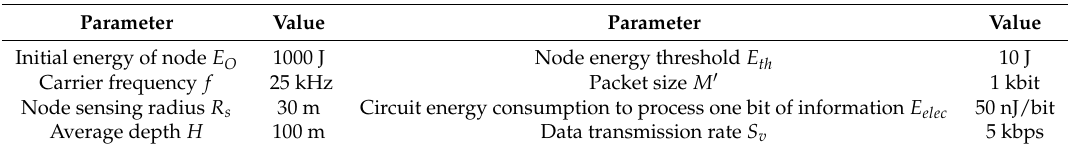
Table 2. Simulation scenarios and parameters.